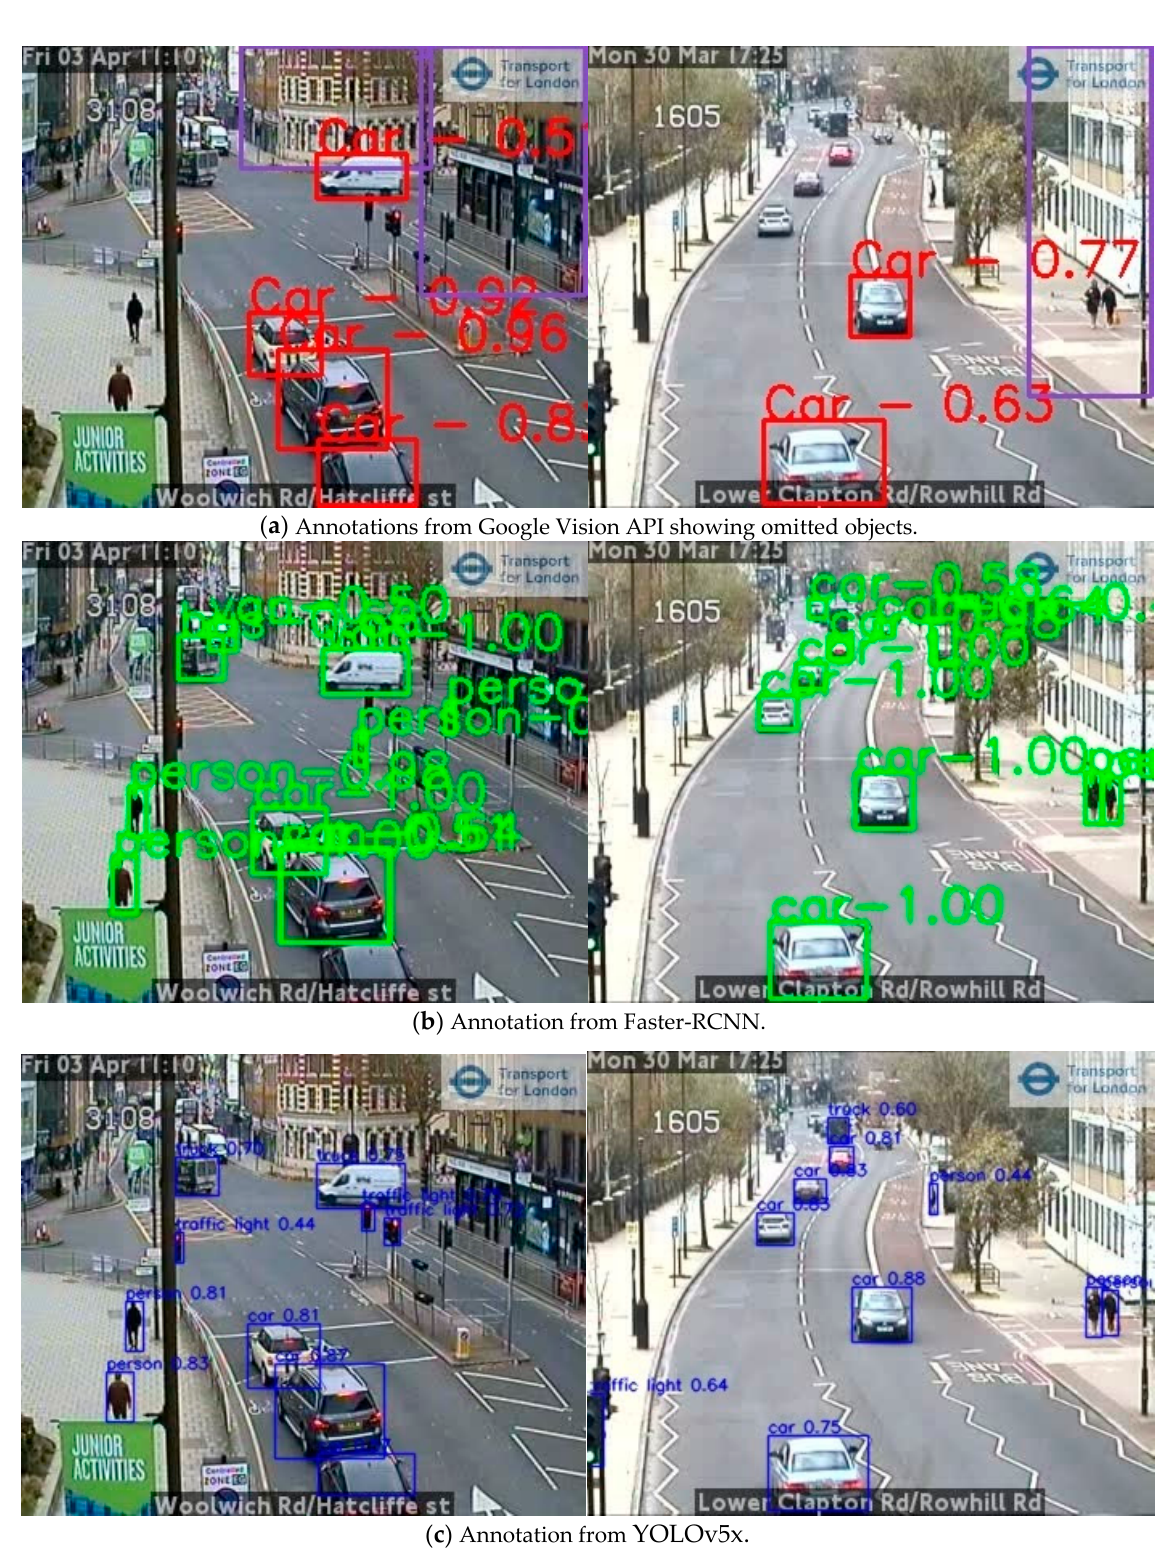
Figure 11. Comparison of automatic annotation results from different object detection models using two example images